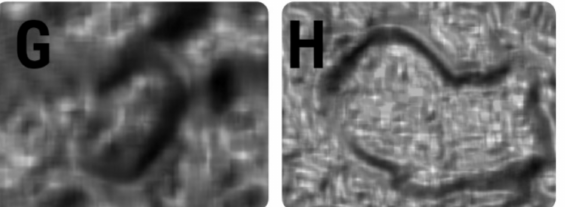
Figure 5. T2-weighted images of ( A ) side-branch IPMN and ( B ) pancreatic pseudocyst. Below each image are the maps that display the distribution of ( C , D ) CH3D6Contrast, ( E , F ) CH5D6InvDfMom, and ( G , H ) RHD6GLevNonU parameters.